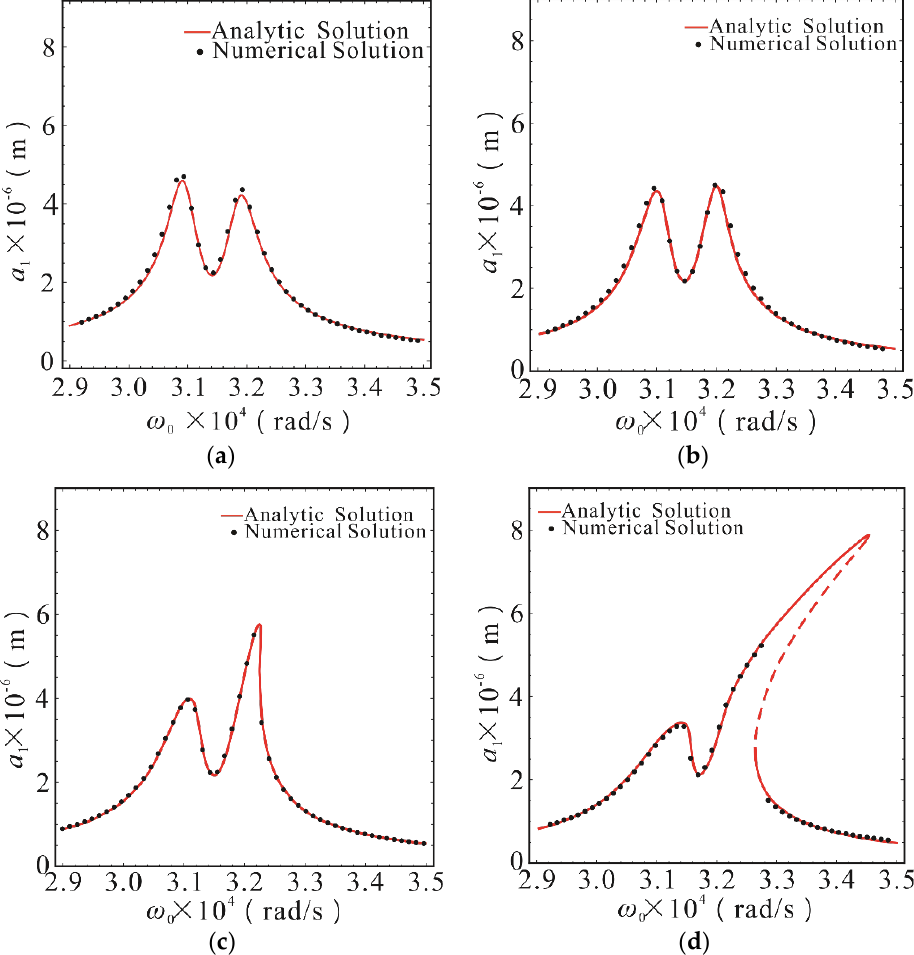
Figure 3. The amplitude-frequency response curves of first-order drive mode with different stiffness nonlinear coefficients in the case of σ 2 = 5.91 × 10 7 . ( a ) The case of K 1 = K 2 = 0; ( b ) The case of K 1 = K 2 = 10 11 N / m 3 ; ( c ) The case of K 1 = K 2 = 10 11.5 N / m 3 ; ( d ) The case of K 1 = K 2 = 10 12 N / m 3 . The point was calculated using the Runge-Kutta method. The line was calculated using the multiple scales method (MMS). The solid lines represent the stable solution. The dashed lines represent the unstable solution.